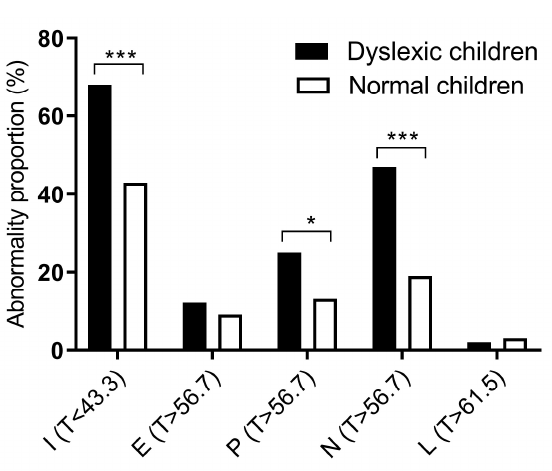
Figure 1. The abnormality proportion of Eysenck Personality Questionnaire (EPQ) scores between the dyslexia and control groups. E is Extroversion, I is Introversion, P is Psychoticism, N is Neuroticism, and L is Dissimulation. T is the standard score calculated by the formula: T = 50 + 10 × (x − m)/SD. N = 240. * p < 0.05, *** p < 0.001.